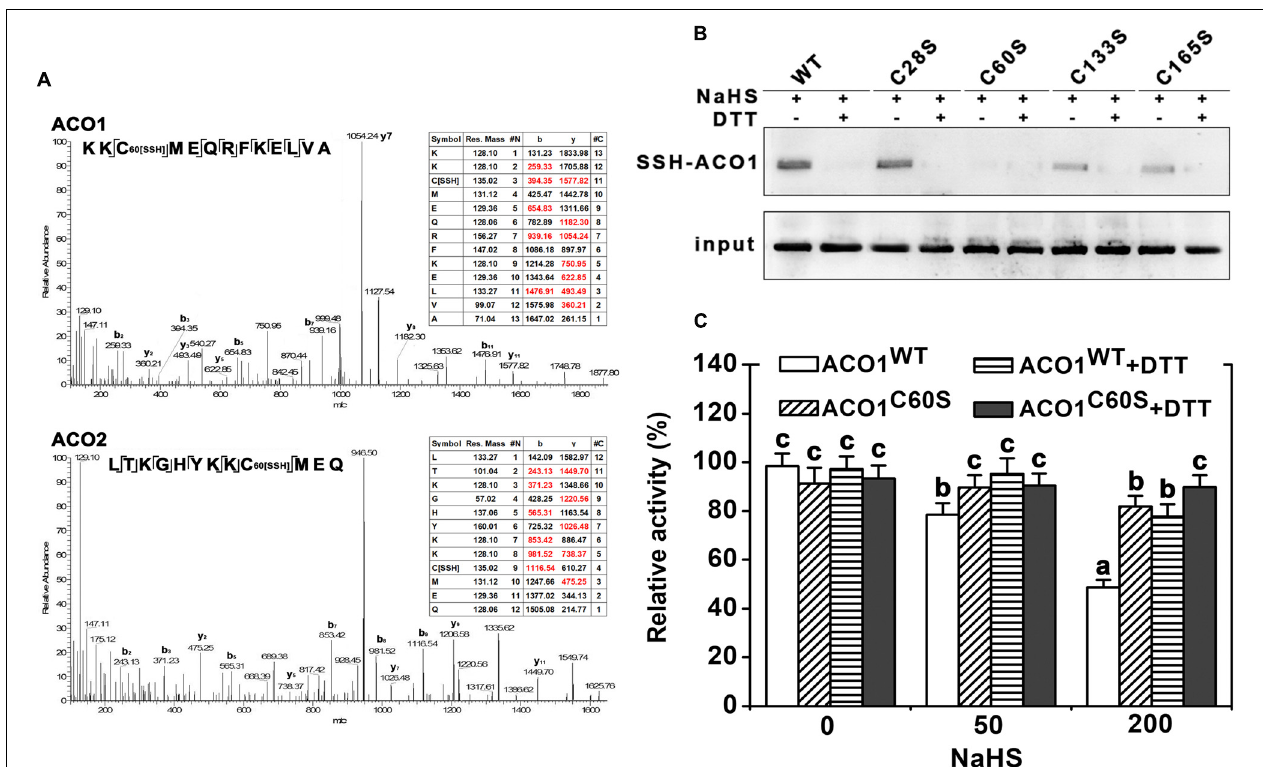
FIGURE 5 | LC-MS/MS analysis of the tryptic peptide containing Cys60 of LeACO1 and LeACO2 recombinant protein (A) . The table inside the spectrum contains the predicted ion types for the modified peptide, and the ions detected in the spectrum are highlighted in red. A 32 D mass shift in Cys60 were included in the analysis of data by Maxquant software. Immunoblot analysis of recombinant LeACO1 mutation proteins (B) . NaHS-induced persulfidation of LeACO1 mutation was detected using a MBST. Recombinant proteins were pretreated with NaHS (200 µ M) and NaHS plus DTT (10 mM) for 20 min, and then the immunoblot analysis carried out. Persulfidated proteins were labeled with biotin and analyzed using an anti-biotin antibody. Input is anti-his signal, which indicate the total protein amount. Analysis of recombinant LeACO1 C60S mutation protein activity (C) . Recombinant proteins were pretreated with NaHS and NaHS plus 10 mM DTT for 20 min, and then enzyme activity was analyzed. Mean values ± SE were calculated from three replicates. Within each set of experiments, bars with different letters are significant different (Duncan’s multiple range tests, P <